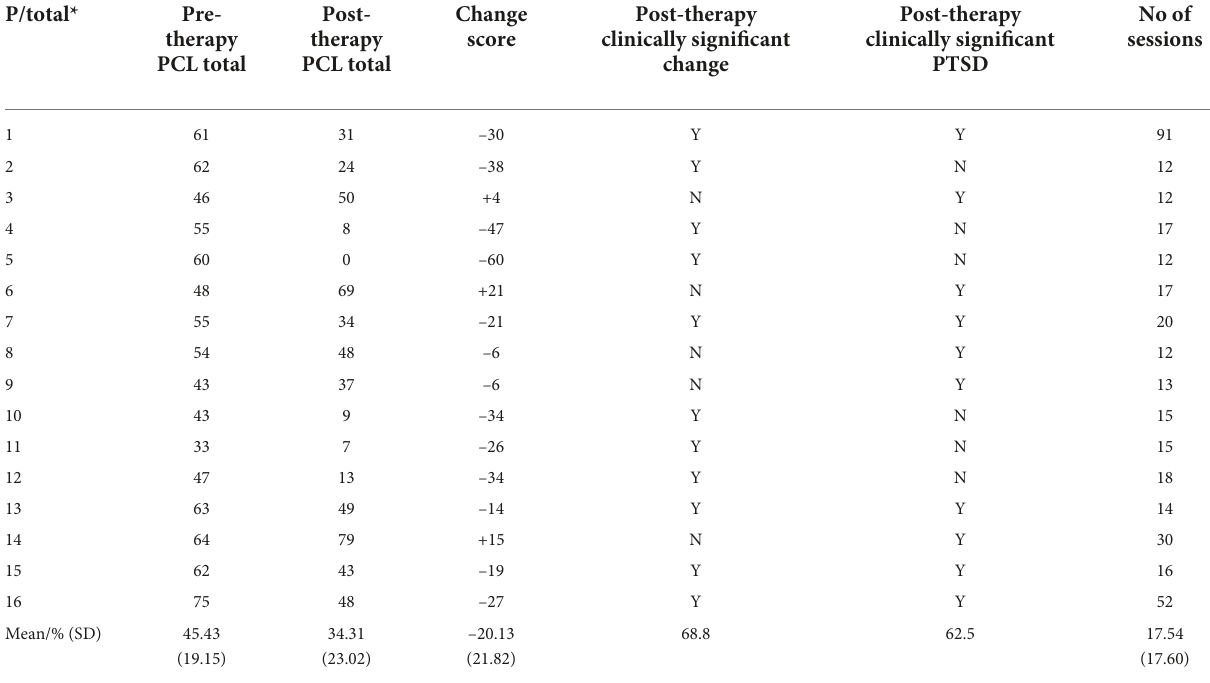
TABLE 2 PCL (PTSD severity) pre and post tf-CBTp, and number of sessions ( N = 16).